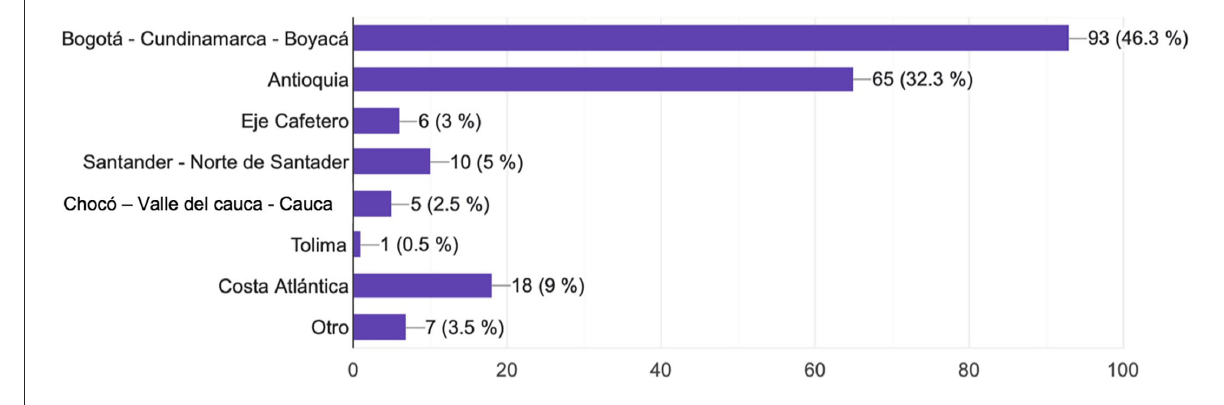
FIGURE1 Colombian regions represented on the survey. All Colombian departments were represented in the survey.